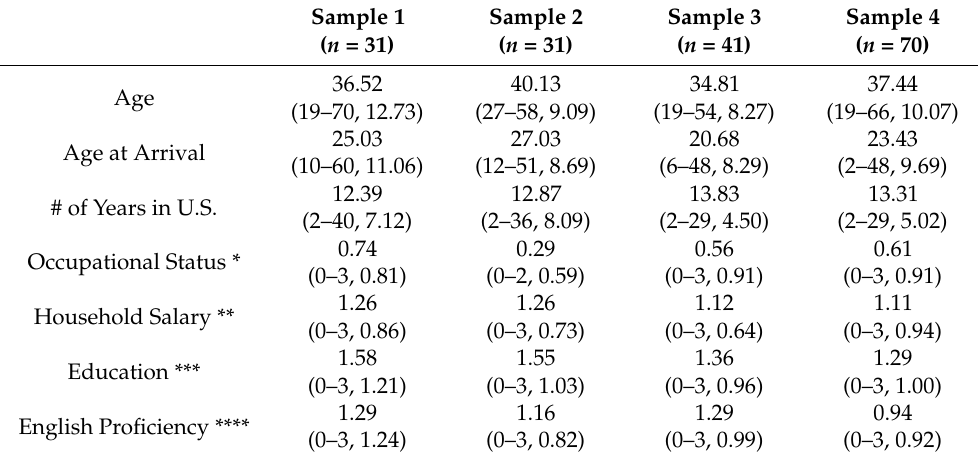
Table 1. Descriptive statistics for Samples 1–4.